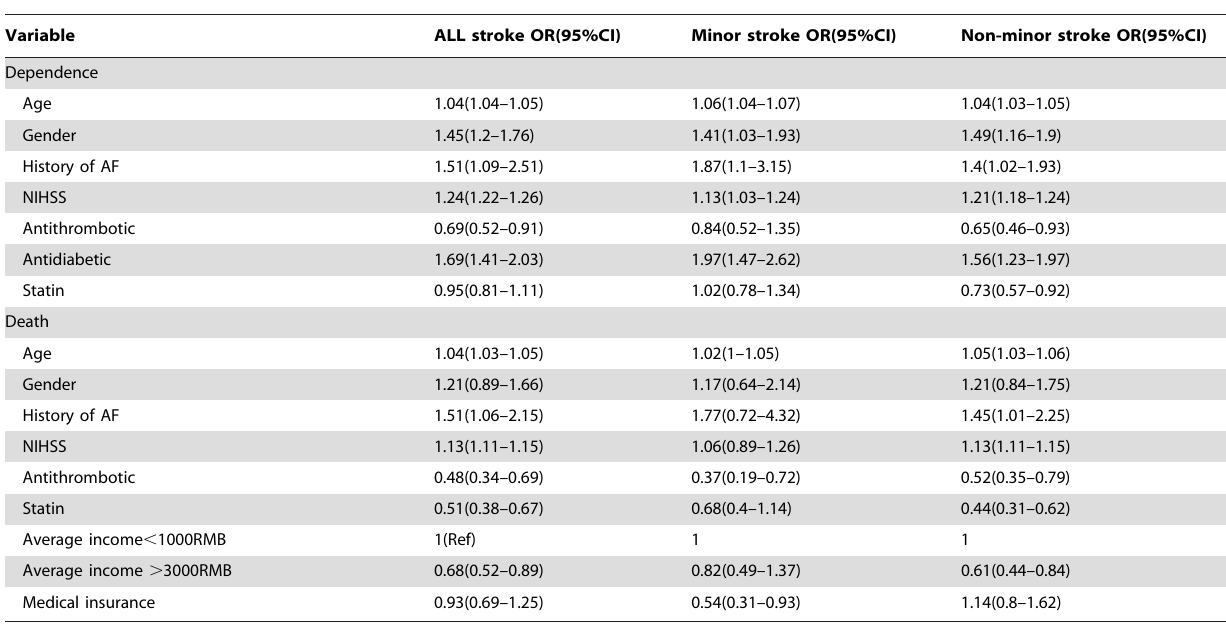
Table 3. Significant Predictors of Clinical Outcome at 3